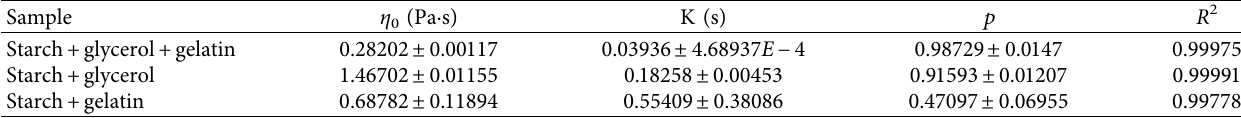
Table 8: The correlation coefficient fitted by the Cross model.